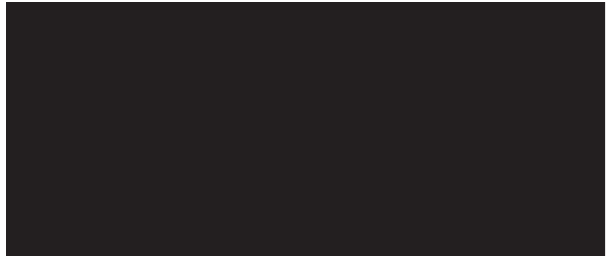
a) Vectors in X-Z Axis Figure 2. CFD prediction of 3-D flow in a quench tank with a single corner- mounted impeller stirrer, a) Vectors in the x-z axis; and b) vectors in the y-axis.